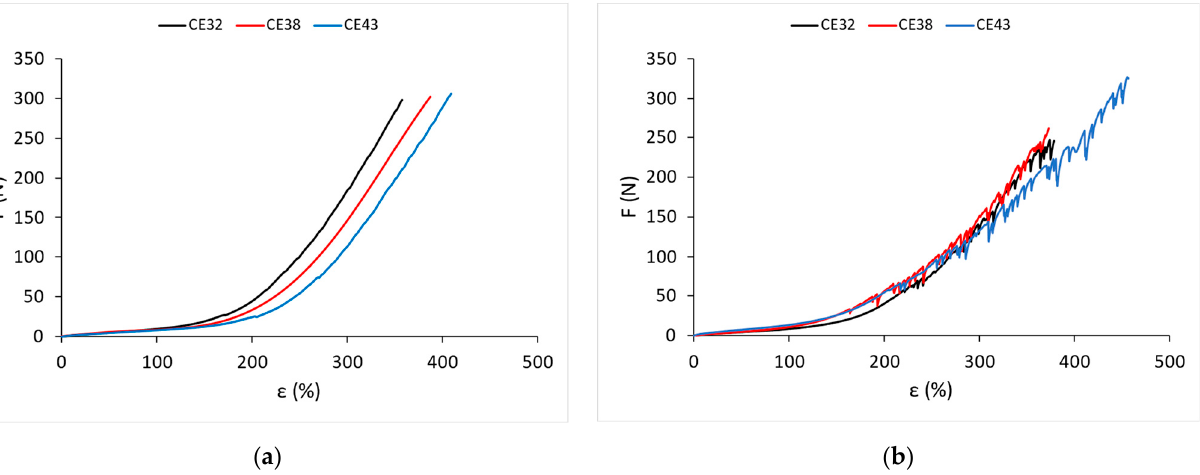
( b ) Figure 5. Force–elongation diagrams for knitted fabric samples with polyamide yarn and wrapped